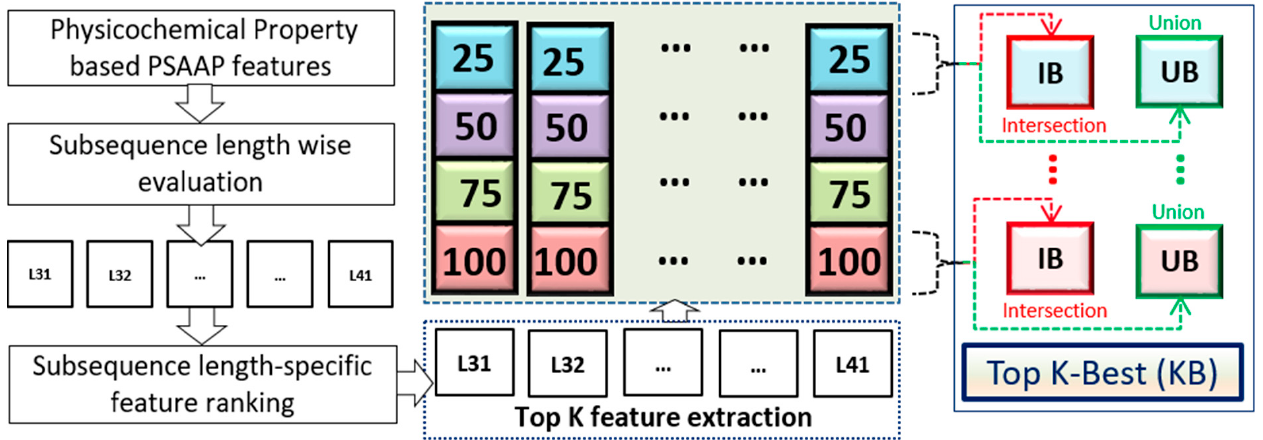
Figure 3. A detailed flow chart for K-Best feature selection.